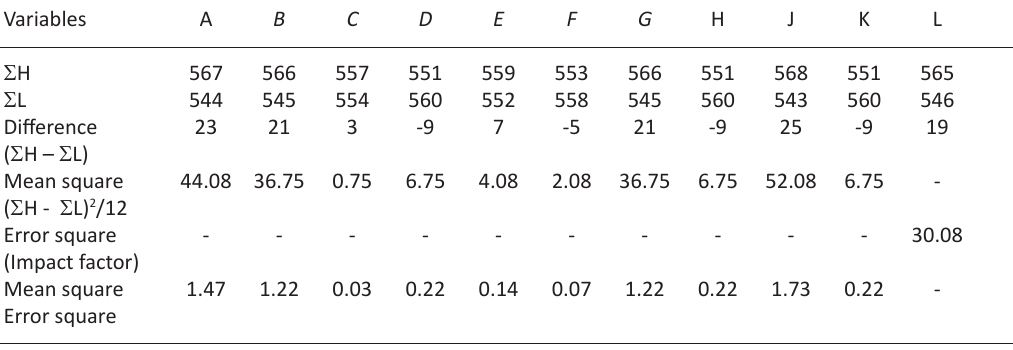
Table 5. Analysis of yields and evaluation of impacts